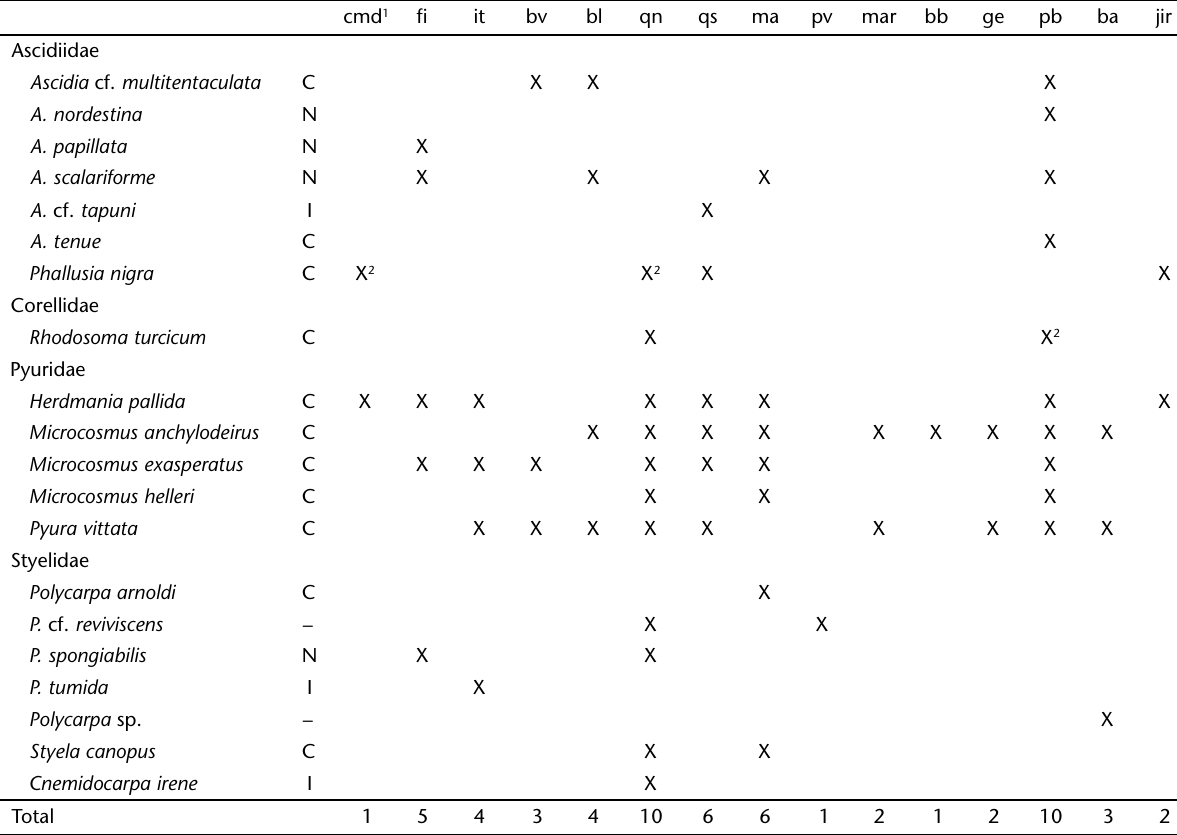
Table II. Spatial distribution of solitary ascidians in Todos os Santos Bay, Bahia and their classification (N = native, C = cryptogenic, I =